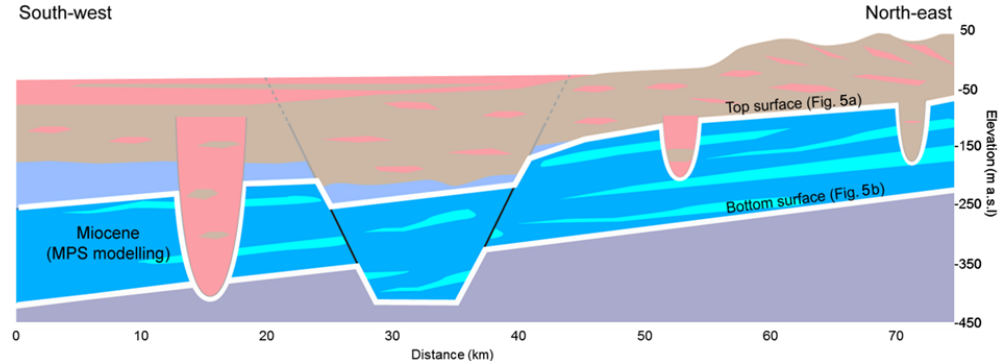
Figure 4. Sketch of the MPS model domain based on the conceptual sketch of the geology in Fig. 3: top and bottom of the Miocene unit is outlined by thick white lines. The surfaces are shown in Fig. 5a and b.